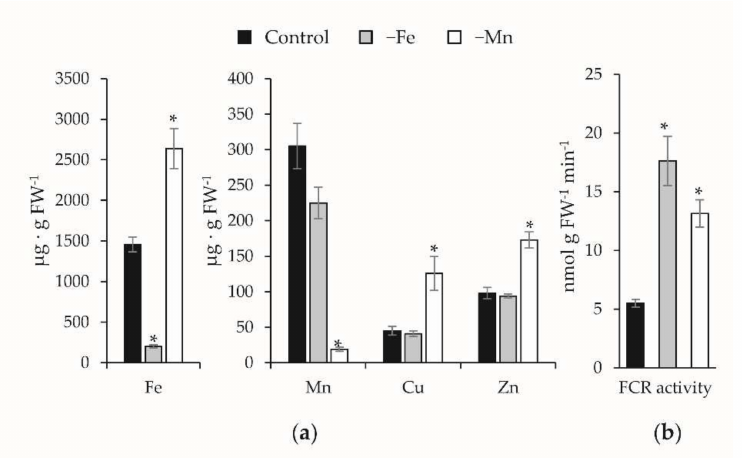
Figure 1. Effect of Fe and Mn deficiency on the root metal concentration ( a ) and Fe reductase (FCR) activity ( b ) (*, t -test p ≤